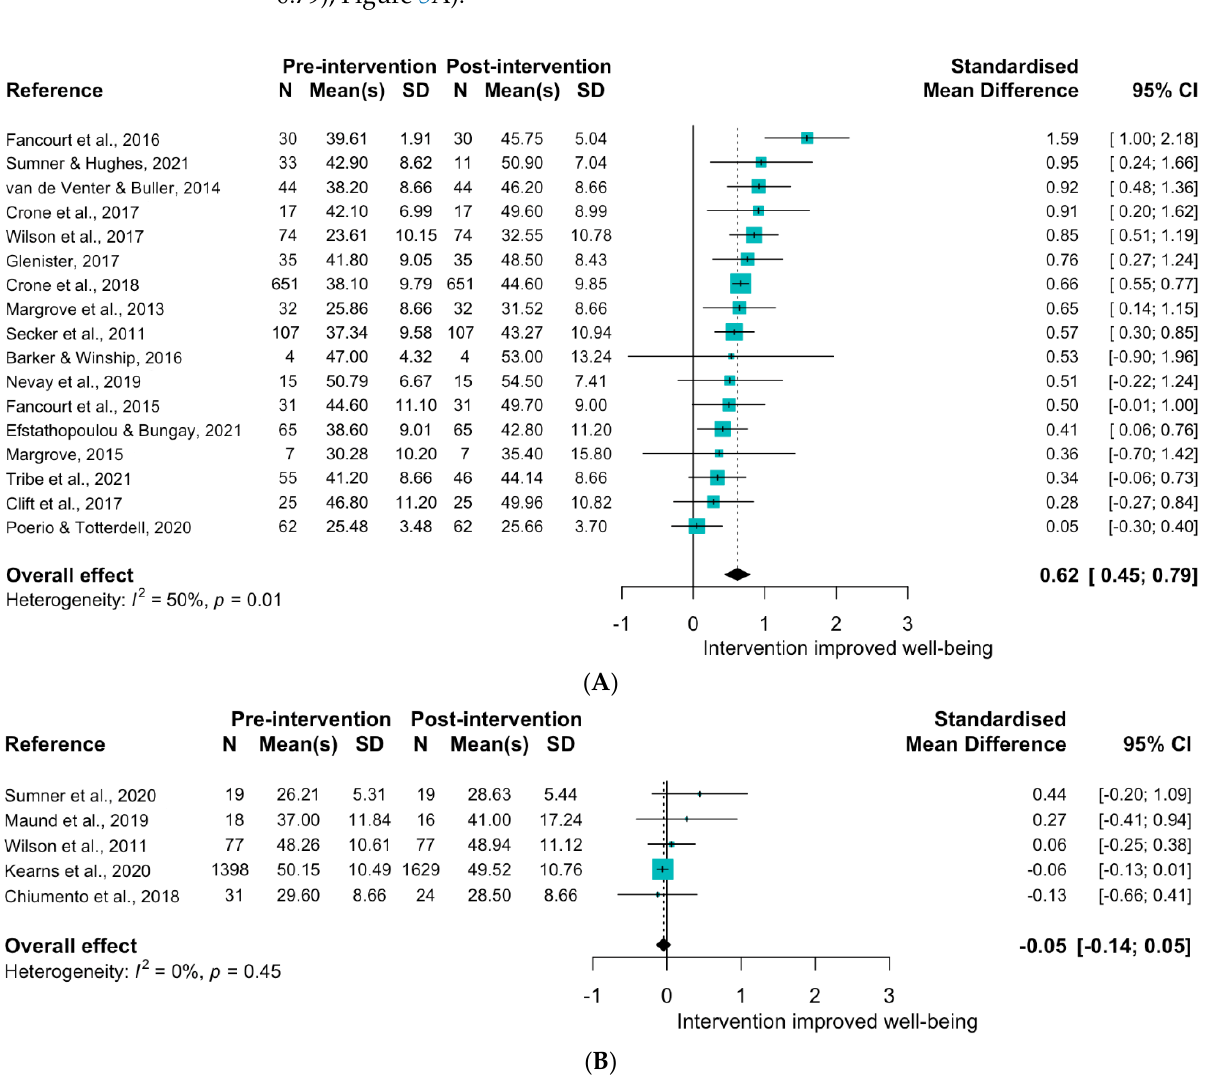
Figure 5. Forest plot indicating change in WEMWBS score from pre to post intervention for Theme 3: ( A ). Art [156–162,164–168,170–174] and ( B ). Environmental interventions [179,181–184]. Change indicated by standardised mean